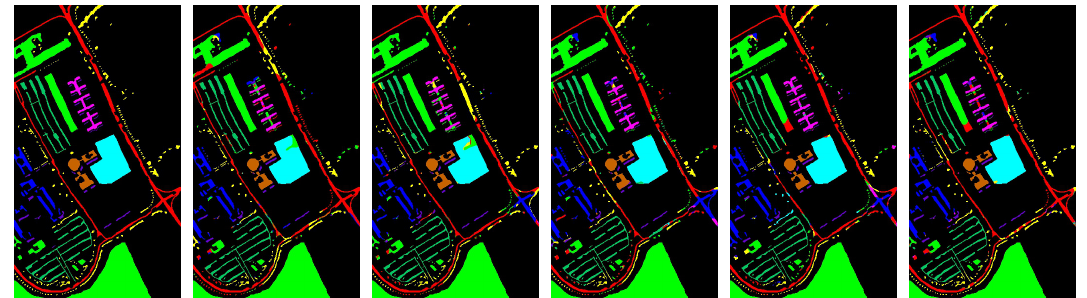
Figure 5. Classification maps on Pavia University. The first map is the groundtruth. The rest ones are predicted by our employed classifier with the random sampling, the least confidence, the entropy sampling, BALD, and our adversarially learned acquisition heuristic (i.e., our FAAL framework), separately. Table 3 lists what class each color represent. Specifically, the part in black means